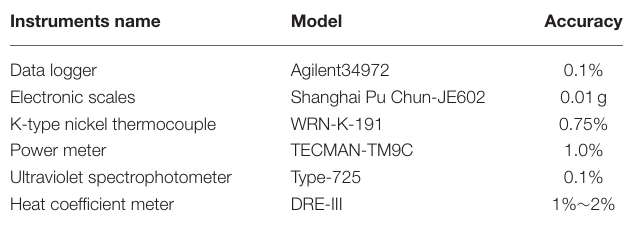
TABLE 2 | Instrument parameters and uncertainty.